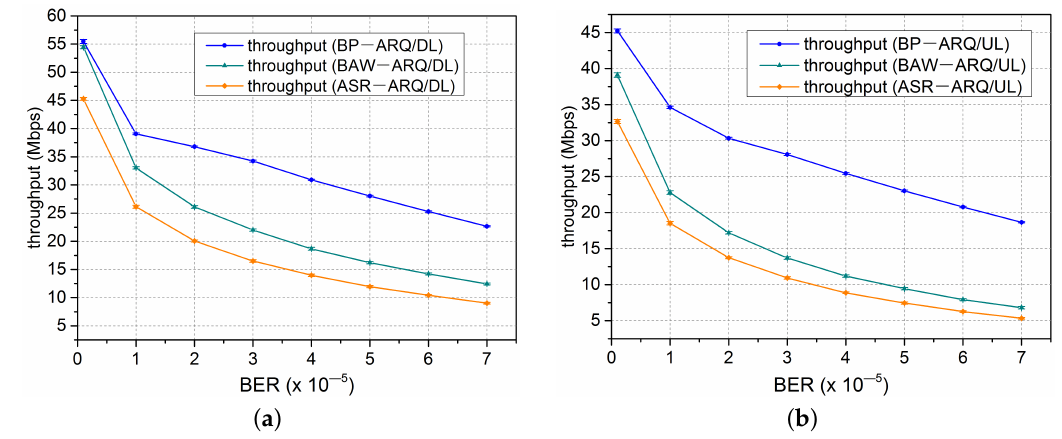
Figure 12. The throughput of each station vs. the bit error rate (BER). ( a ) downlink. ( b )